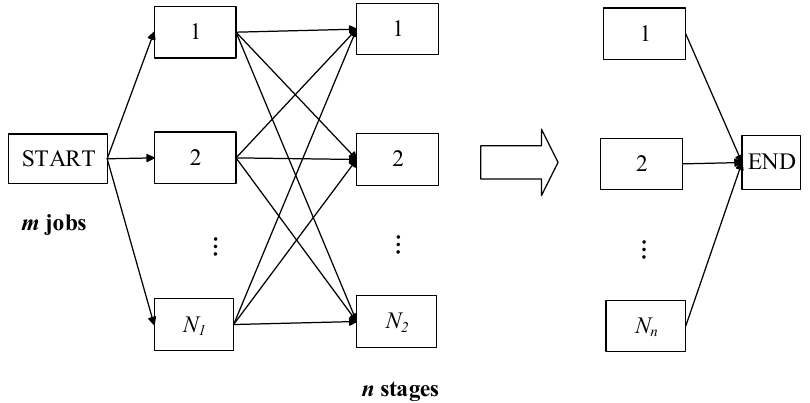
Figure 4. The layout of the hybrid flow shop scheduling problem (HFSP).